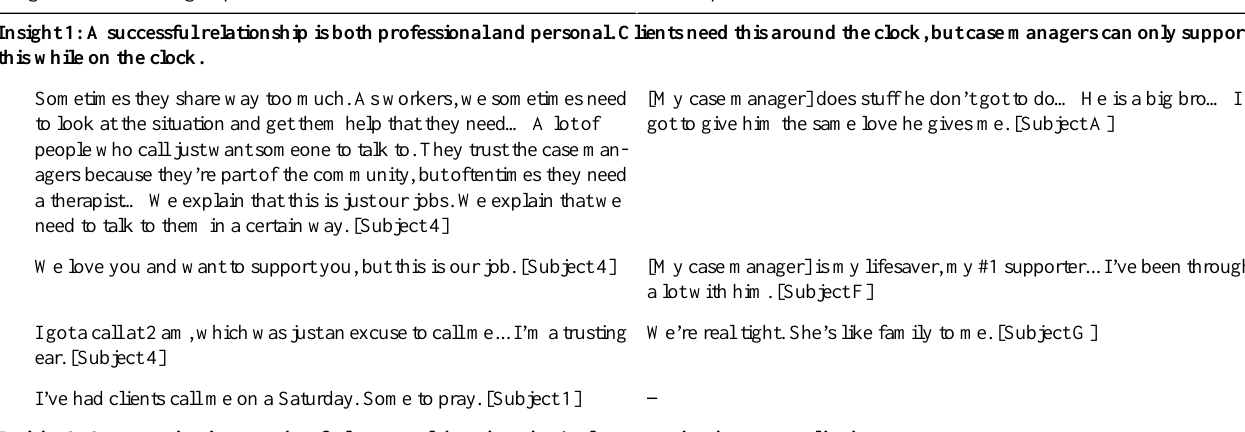
Client quotationsInsight and case manager